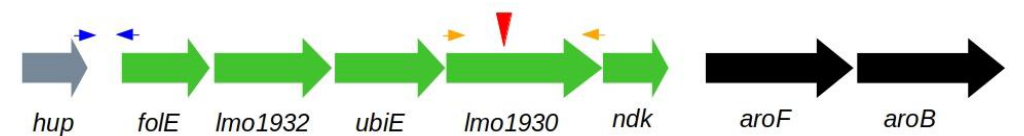
Figure 1. Organization of the lmo1930 genomic region in L. monocytogenes EGD-e. Genes belonging to the lmo1930 operon as described by Toledo-Arana et al. (2009) are indicated in green. Downstream genes aroF and aroB belonging to the aroF aroB lmo1926 hisC tyrA aroE operon (Toledo-Arana et al. (2009) are in black. The transposon insertion in lmo1930 is indicated with a downwards-pointing red triangle. Primers H1H3compsoeA and H1H3compsoeB used for amplification of the upstream regulatory region are indicated with blue arrows. Primers H1H3compsoeC and H1H3compsoeD used for amplification of the lmo1930 coding region are indicated with orange arrows.